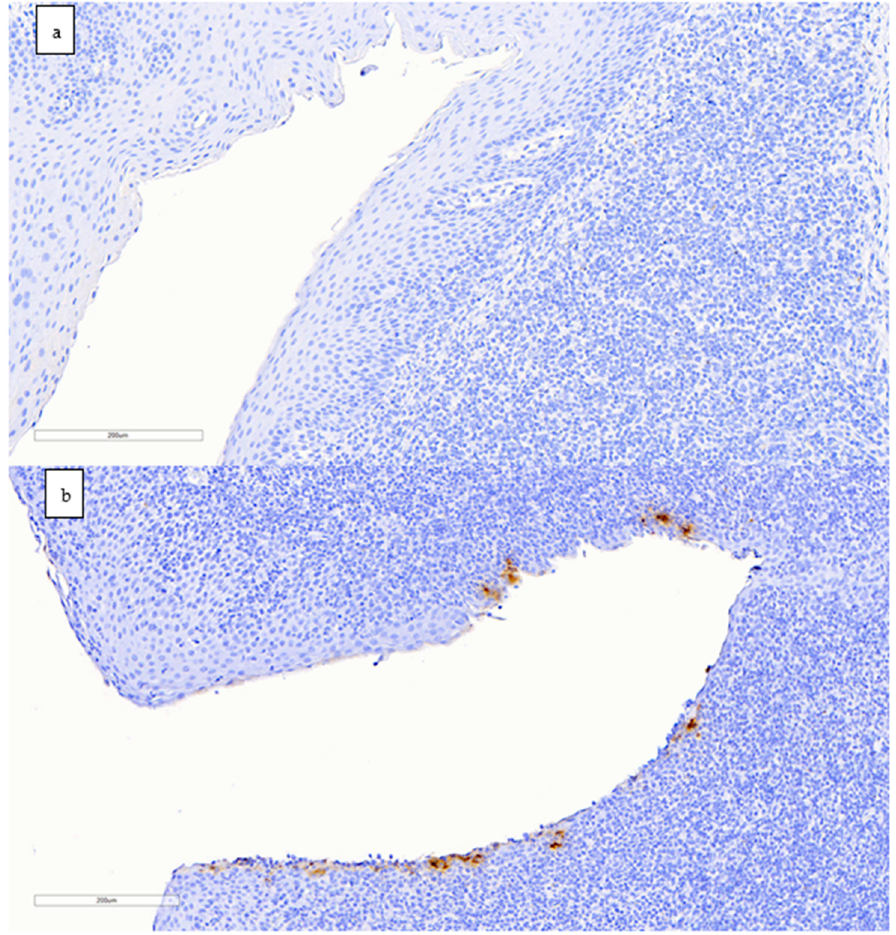
Figure 4. Immunohistochemistry staining to detect the nucleocapsid protein of SARS-CoV-2 in goat tonsils (scale bar: 200 μ m). ( a ) Negative control animal with no antigen labelling. ( b ) Positive result in the tonsil of a goat euthanised at 2 dpi; immunolabelling is seen as brownish staining in dendritic-like cells around a tonsillar crypt.